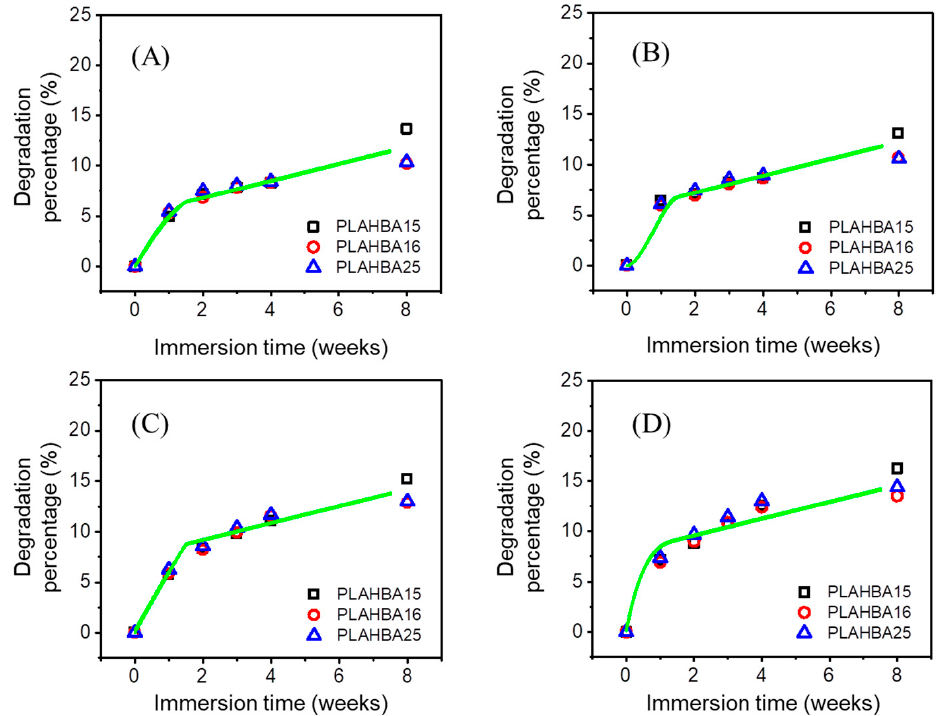
Figure 4. Evolution of weight loss percentage of degradable PLA/PHB fabrics under multiple environmental parameters: ( A ) static seawater, ( B ) aerated seawater, ( C ) UV-lighting static seawater, and ( D ) UV-lighting aerated seawater. Note: all the discrete scatter points represent the experimental mass-loss percentage data of PLA/PHB fabrics under static seawater and/or UV-lighting aerated seawater. The green line represents the predicted data of PLA/PHB fabrics under static seawater and/or UV-lighting aerated seawater generated by the ANN model.